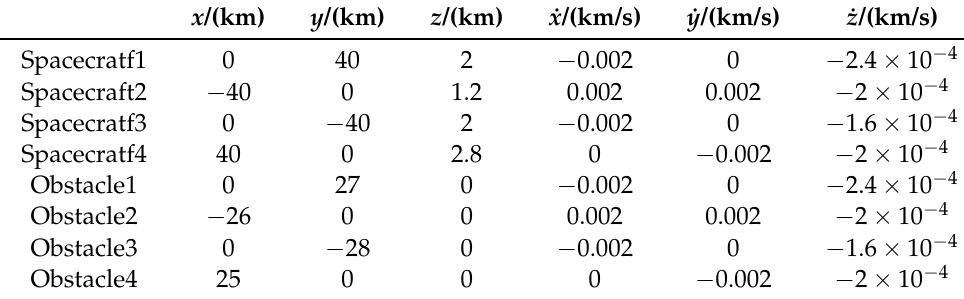
Table 4. Initial relative state parameters of the spacecraft and obstacles.